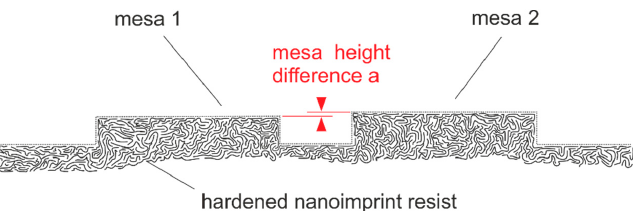
Figure 13. Schematic to visualize the vertical resolution limits in 3D nanoimprint lithography de- fining mesa structures of different heights. The resist is depicted via schematic organic molecules. The size relations are not to scale: vertical mesa height difference of a = 0.2 nm to 1 nm, lateral mesa width of 6 to 40 µm, and vertical mesa heights 10 to 300 nm. The dotted line is drawn to guide the eye to visualize a 3D surface structure.